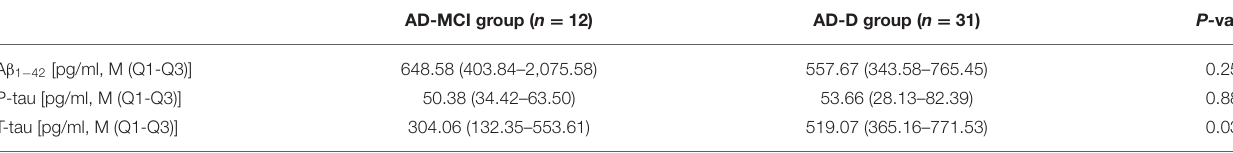
TABLE 5 | Comparisons of neuropathological biomarkers of AD between the AD-MCI and AD-D groups. AD-MCI group ( n = 12)